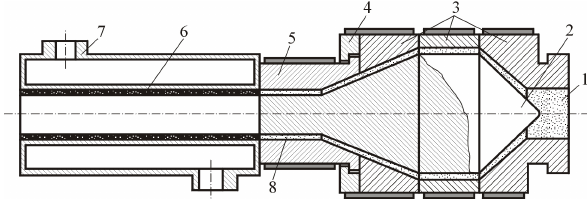
Figure 3: Diagram of Celuka extruder method,